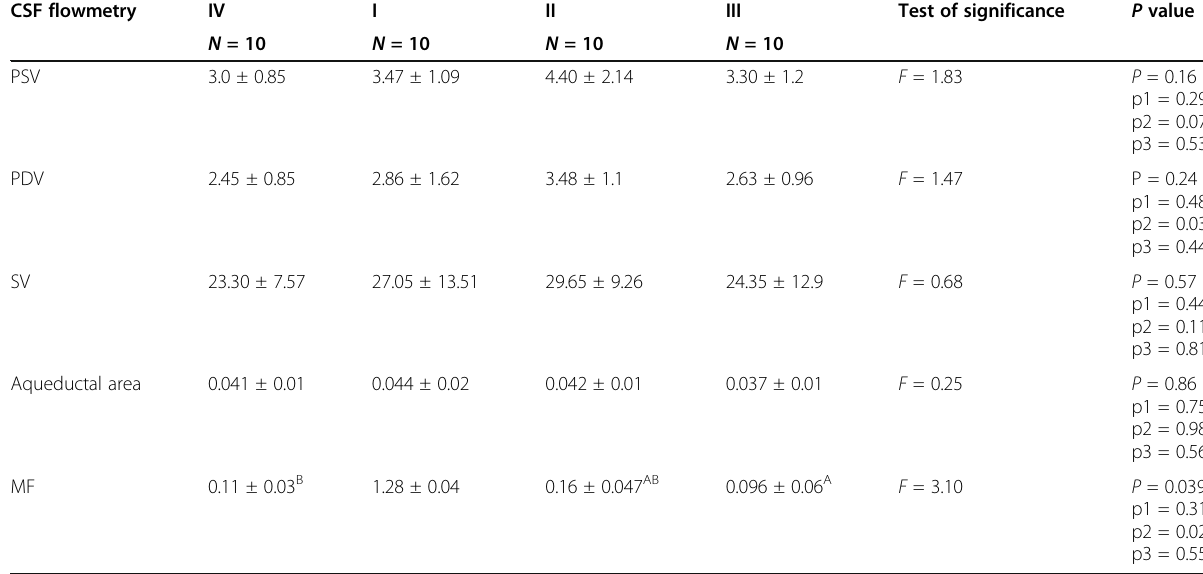
Table 2 Parameters of CSF flowmetry between cases and control group CSF flowmetry